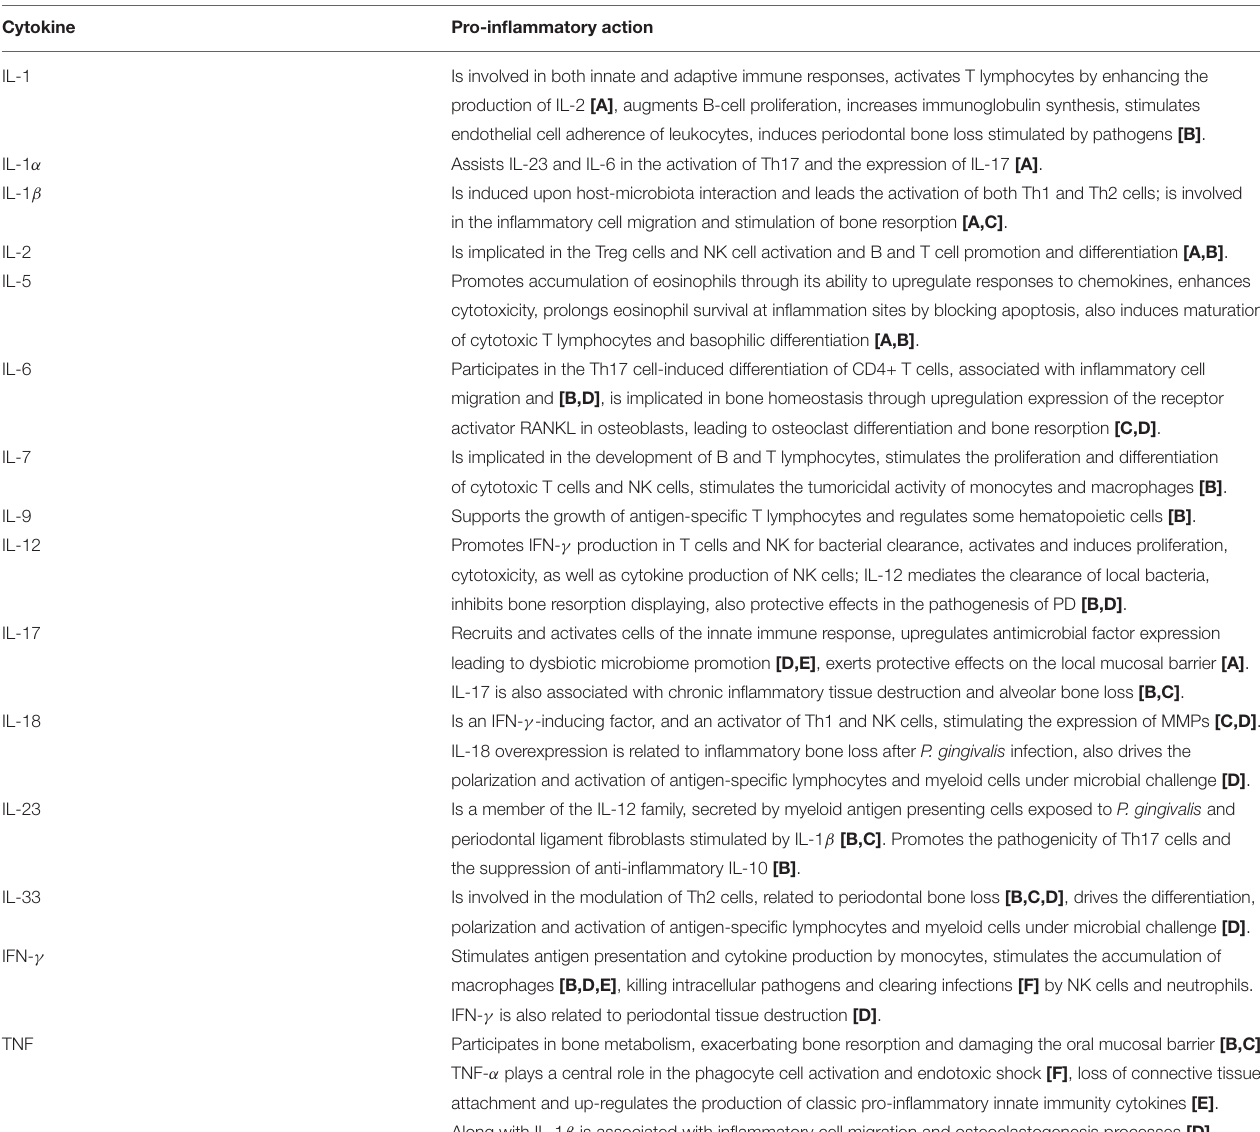
TABLE 1 | Brief overview of pro-inflammatory cytokines involved in periodontal disease. Cytokine Pro-inflammatory